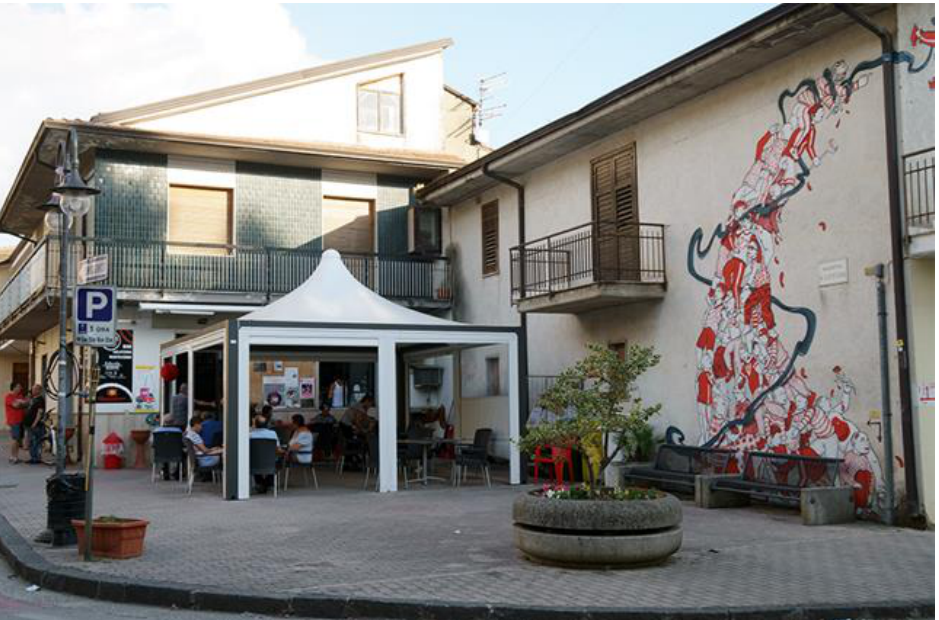
Figure 65. San Michele di Serino: detail of Cotone Street in which there were phenomena liquefaction triggered by the earthquake [22], (photos by